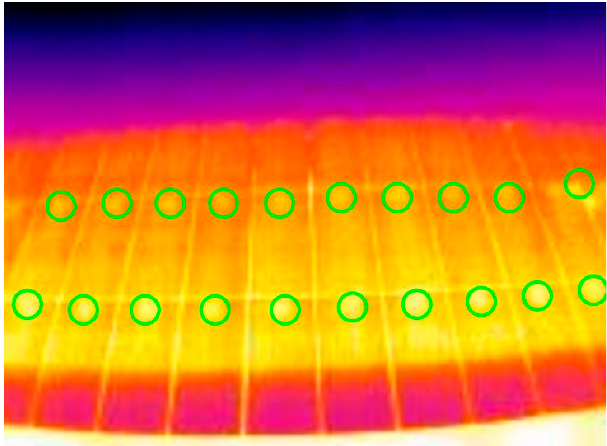
Figure 14. Image with the hot-spots per junction box highlighted in green circles.